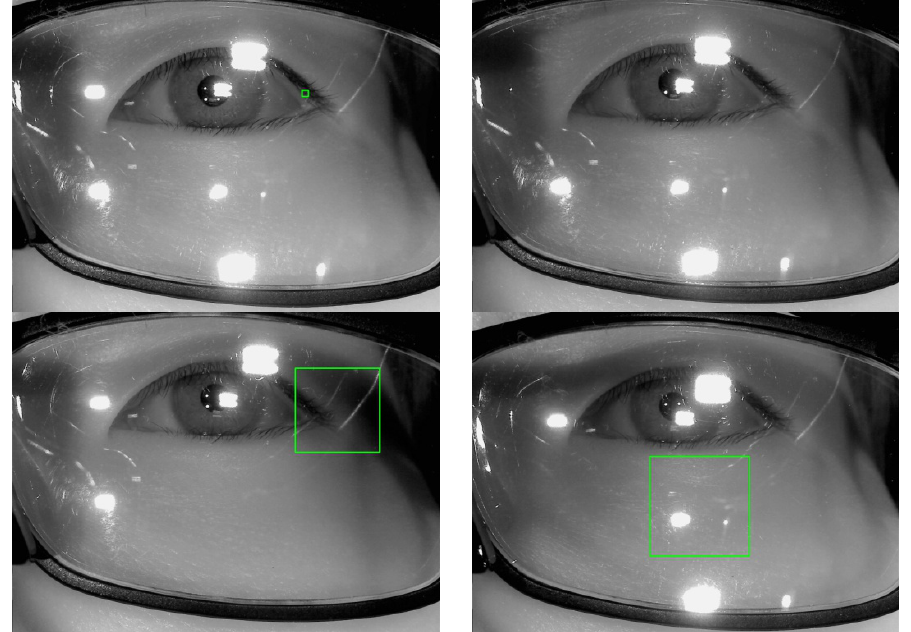
Figure 6. Examples of incorrect detections of the eye region while using the Adaboost eye detector for images that include reflections (We show the results for images in Figure 5a,c–e in the clockwise direction from the top-left